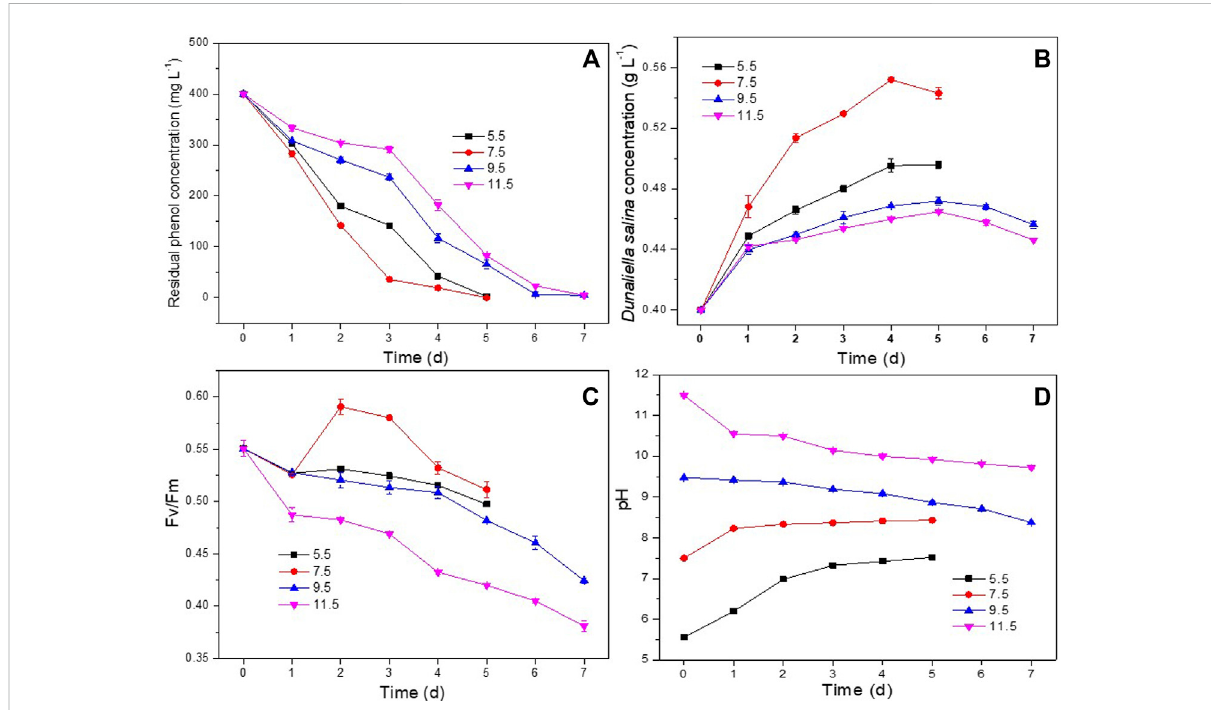
FIGURE 3 Effect of pH on phenol degradation and the growth of D. salina : the residual phenol concentrations (A) , biomass concentrations (B) and Fv/Fm values (C) of D. salina and pH of culture medium (D) under 0.4 g L − 1 D. salina , 0.2 g L − 1 H. mongoliensis , 120 μ mol m − 2 s − 1 and 25 ° C conditions.